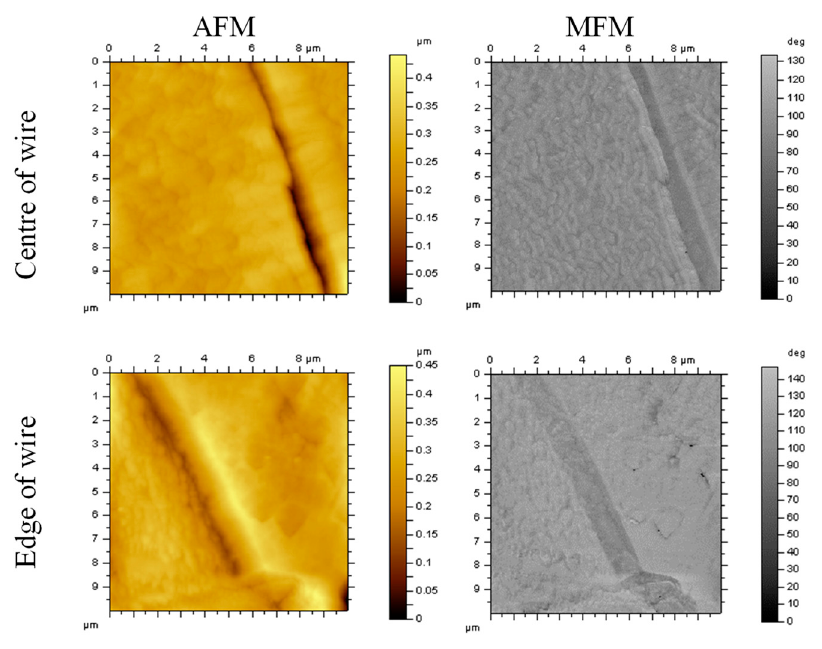
Figure 11. Deviation of saturation magnetic induction Bs with the change of strain.